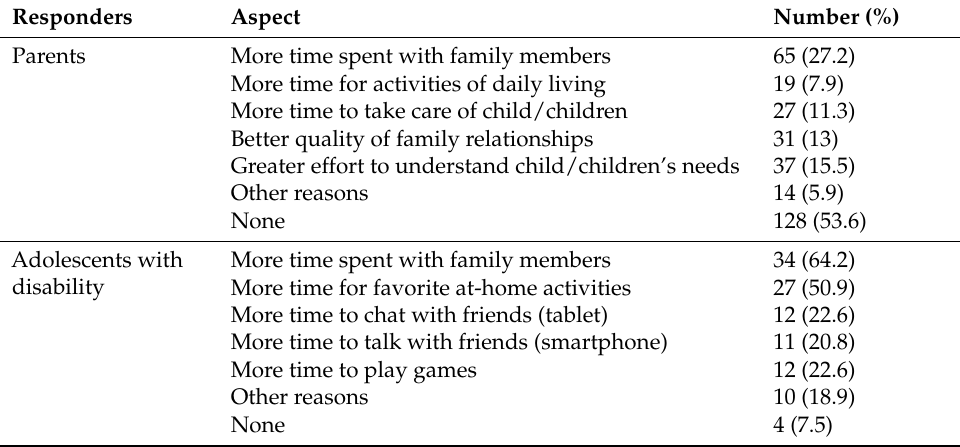
Table 3. Positive aspects of